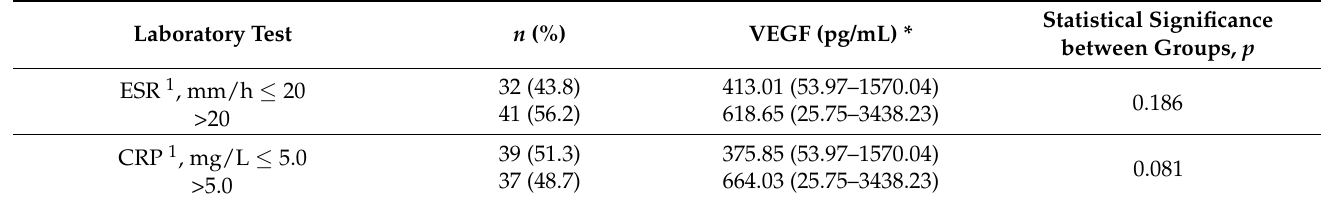
Table 7. VEGF level distribution between undifferentiated arthritis patient cohort laboratory test